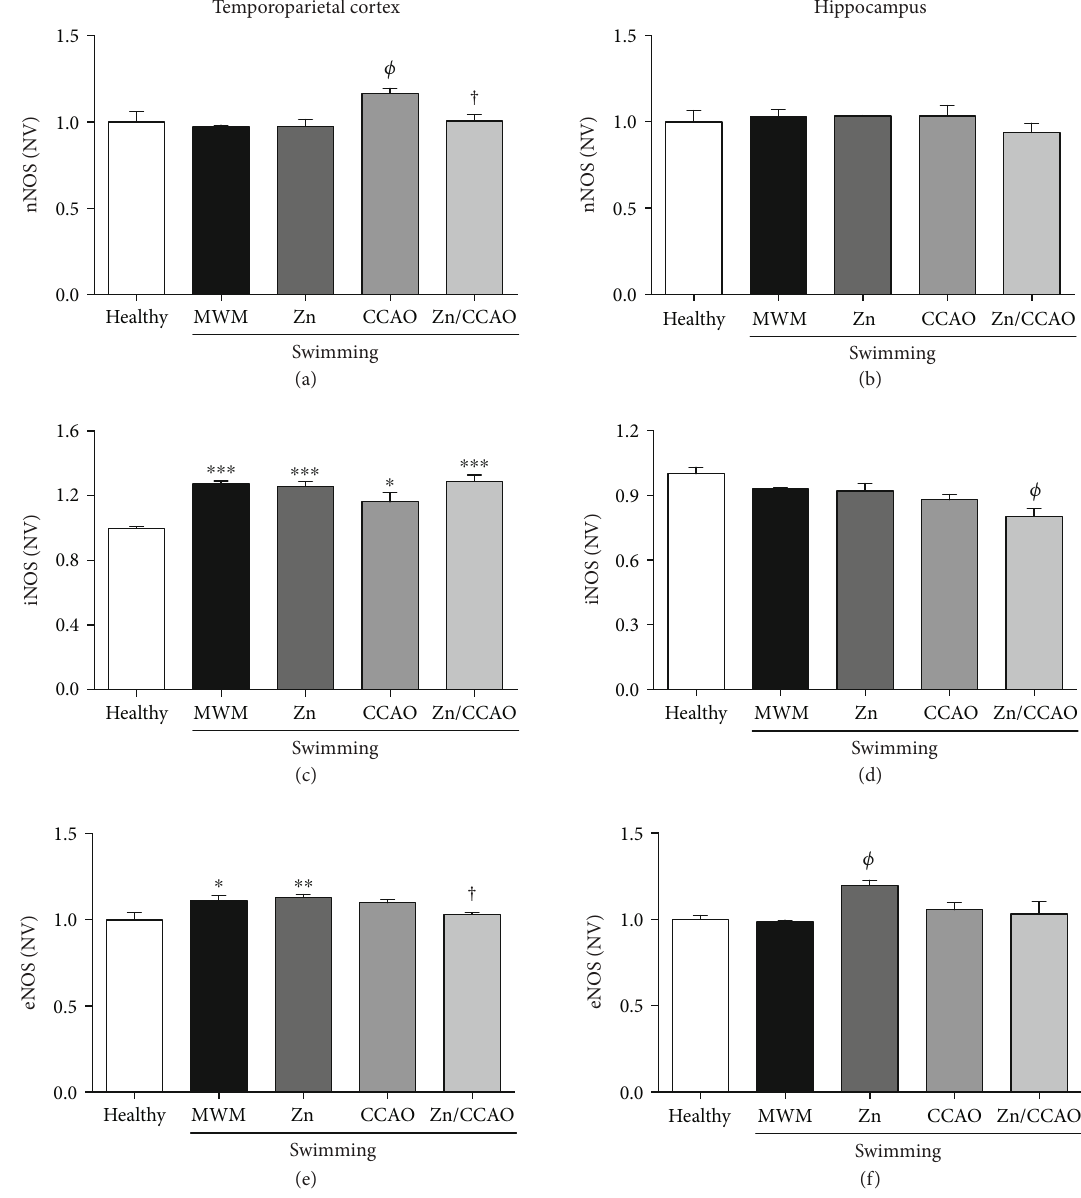
Figure 5: The subacute prophylactic zinc and swimming administration prevented increased nNOS and iNOS levels only in the temporoparietal cortex of rats with 30min CCAO on day 12 postreperfusion. The values are mean ± SEM ( n = 4 ) and analyzed with one- way ANOVA and Dunnett ’ s post hoc multiple comparisons. P < 0 : 05 , ∗ compared with the healthy group, Φ compared with the MWM group and † compared with the CCAO group. NV: normalized values; nNOS: neuronal nitric oxide synthase; iNOS: inducible nitric oxide synthase; eNOS: endothelial nitric oxide synthase.